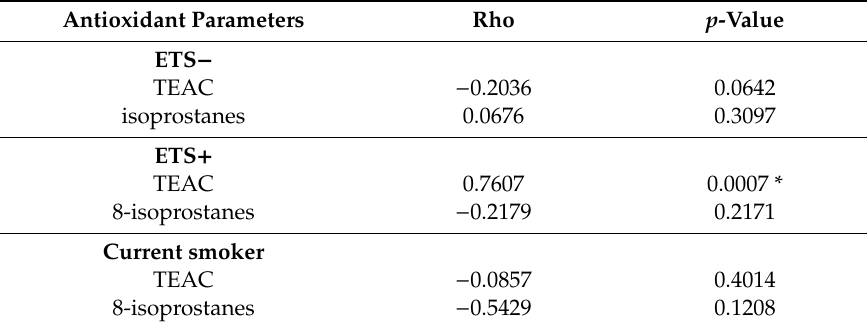
Table 6. Correlations between cotinine levels in urine and oxidative stress